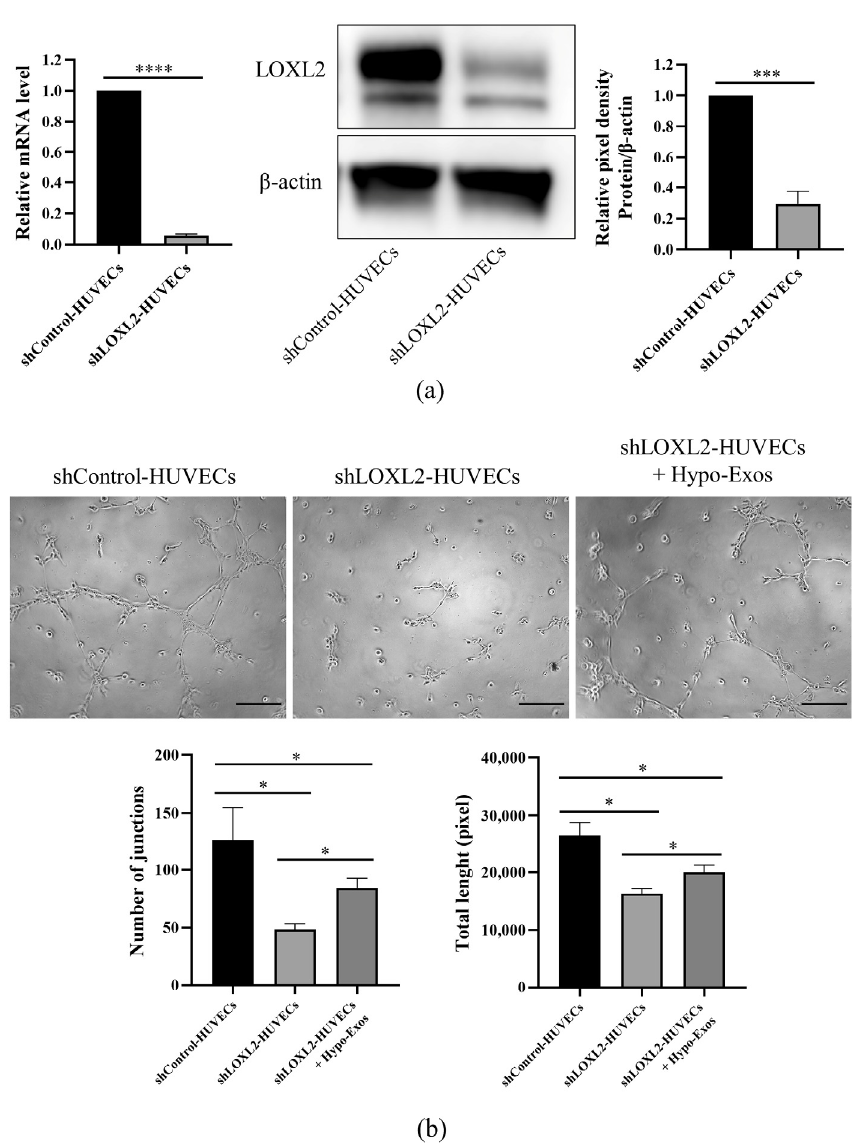
Figure 8. LOXL2 knockdown in HUVECs and tube formation rescue experiment. ( a ) LOXL2 mRNA and protein expression levels were detected by quantitative real-time PCR analysis and Western blot analysis. ( b ) Hypo-Exos partially rescued the angiogenesis of shLOXL2-HUVECs in the Matrigel-based tube formation assay. n = 3, mean ± SD, * p < 0.05, *** p < 0.001, **** p < 0.0001. Scale bars: 200 μ m ( b ).